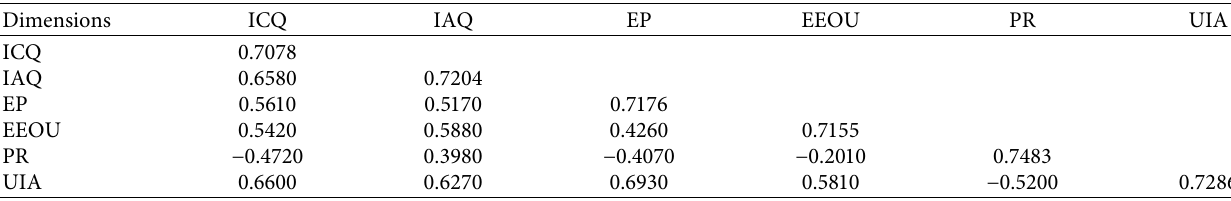
Table 6: Square roots of AVE and correlation coefficients of variables.